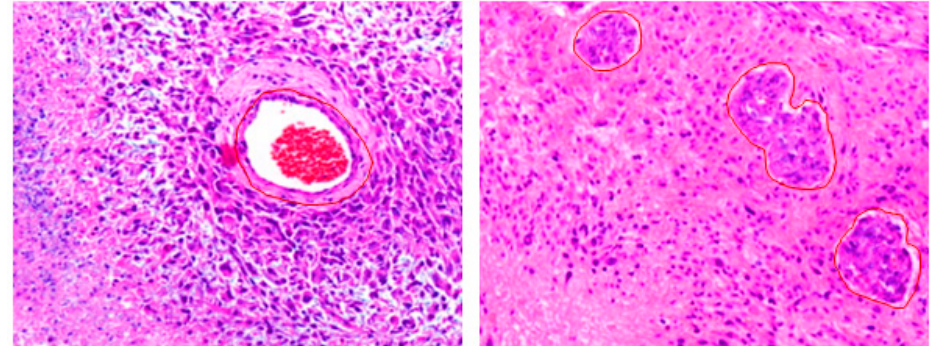
Figure 4. Glioblastoma (grade-IV) tumors. Left: An island of viable tumor cells encircling the blood vessels in a large necrotic focus. Right: Tumor is experiencing endothelial proliferation. The image shows glomeruloid vessels and endothelial multilayering as a result of endothelial hyperplasia. These changes are driven by Vascular Endothelial Growth Factor.secreted by the tumor in response to hypoxia. The images were acquired using 20 × magnification factor.